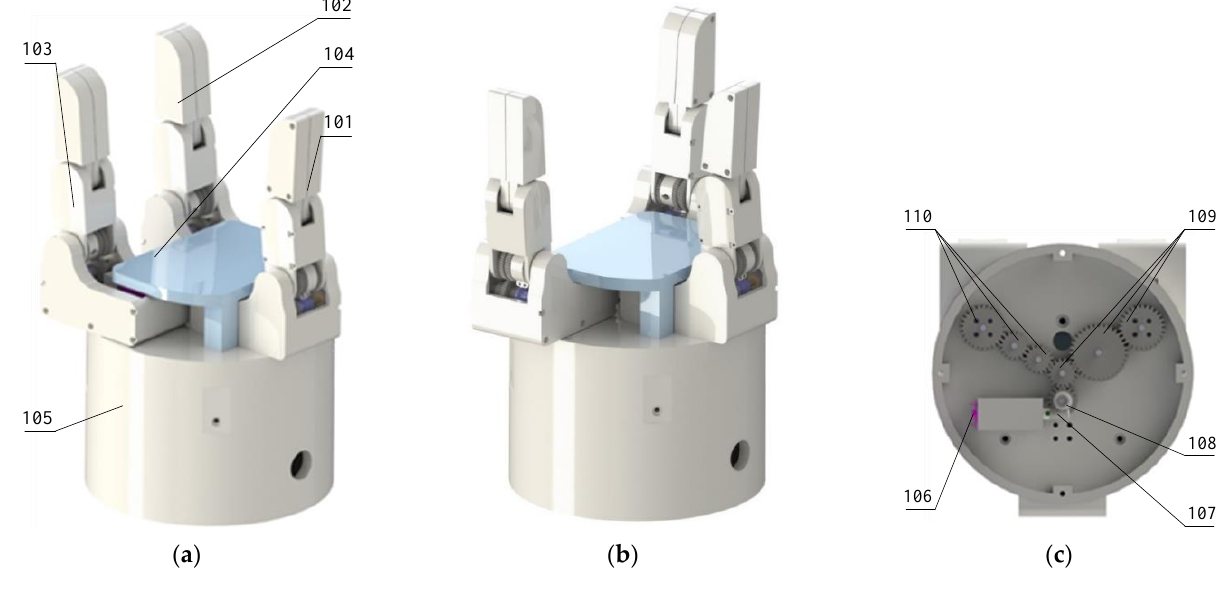
Figure 7. Mechanical structure of the ESMGM hand: ( a ) left isometric view; ( b ) right isometric view; ( c ) bottom view. Components: 101 – 103 — ESMGM fingers; 104 — palm; 105 — base; 106 — palm motor; 107 — palm worm; 108 — palm worm gear; 109 — first rotating gear set; 110 — s rotating gear set.